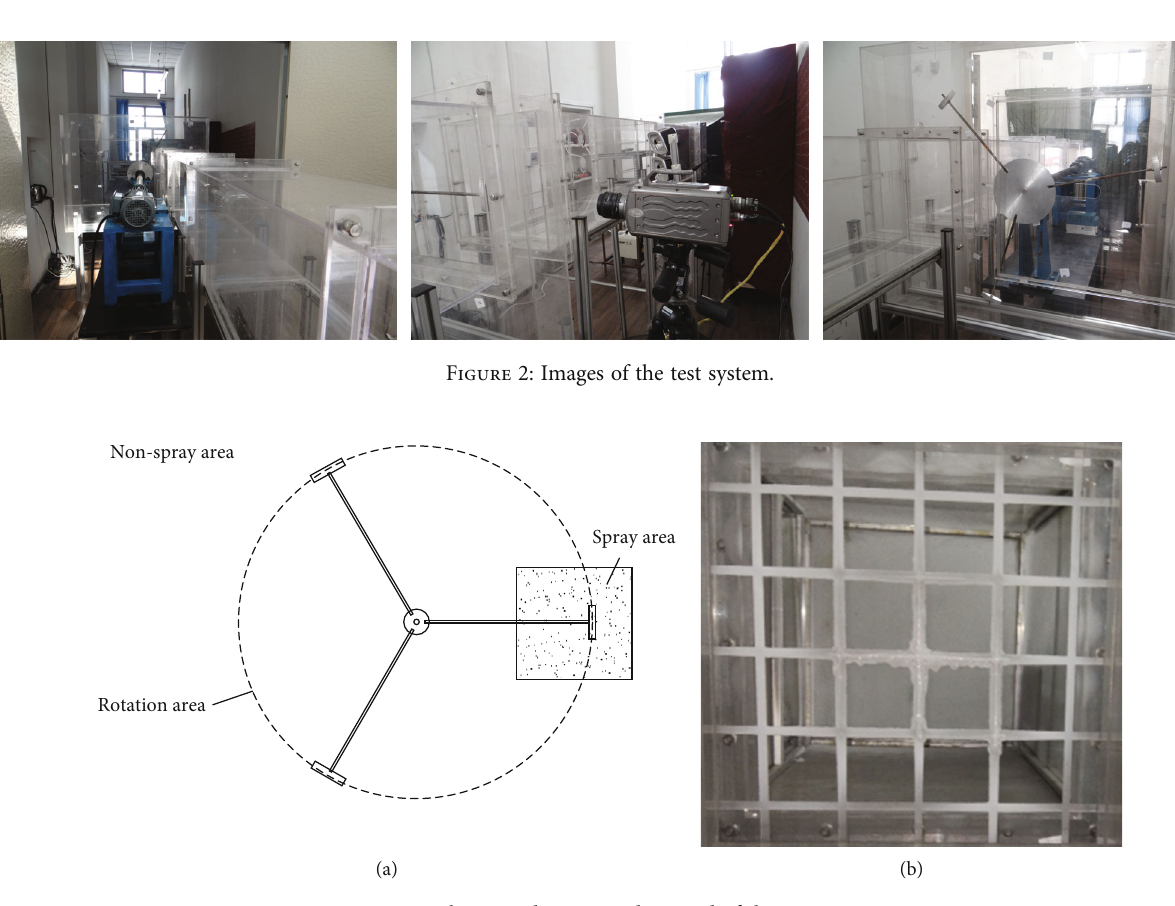
Figure 3: Schematic diagram and ice grid of the test